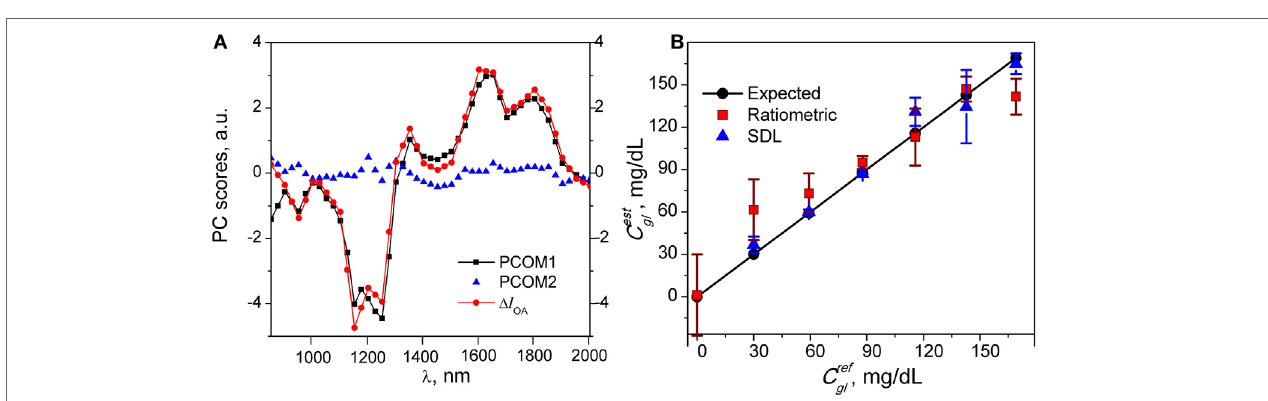
FIGURe 4 | (A) Scores of PCA component (PCOM1) (black squares) and PCOM2 (blue triangles) of principal component analysis of the optoacoustic spectroscopy (OAS) of glucose. For illustration purpose, PCOM readouts are overlaid with near-infrared-optoacoustic spectroscopy (NIR-OAS) Δ I OA (red circles) of 169 mg/dl glucose solution. Note that PCOM1 accounts for ~96.6% of variation over the entire spectral range and follows faithfully the NIR-OAS of glucose, whereas PCOM2 exhibits random behavior. (B) Estimated C gl values for a probe set using ratiometric (red dots) and sparse dictionary learning (SDL) method (blue triangles) with a solid line representing expected C gl from PS values. Note tighter correlation of expected C gl with C gl calculated by SDL.